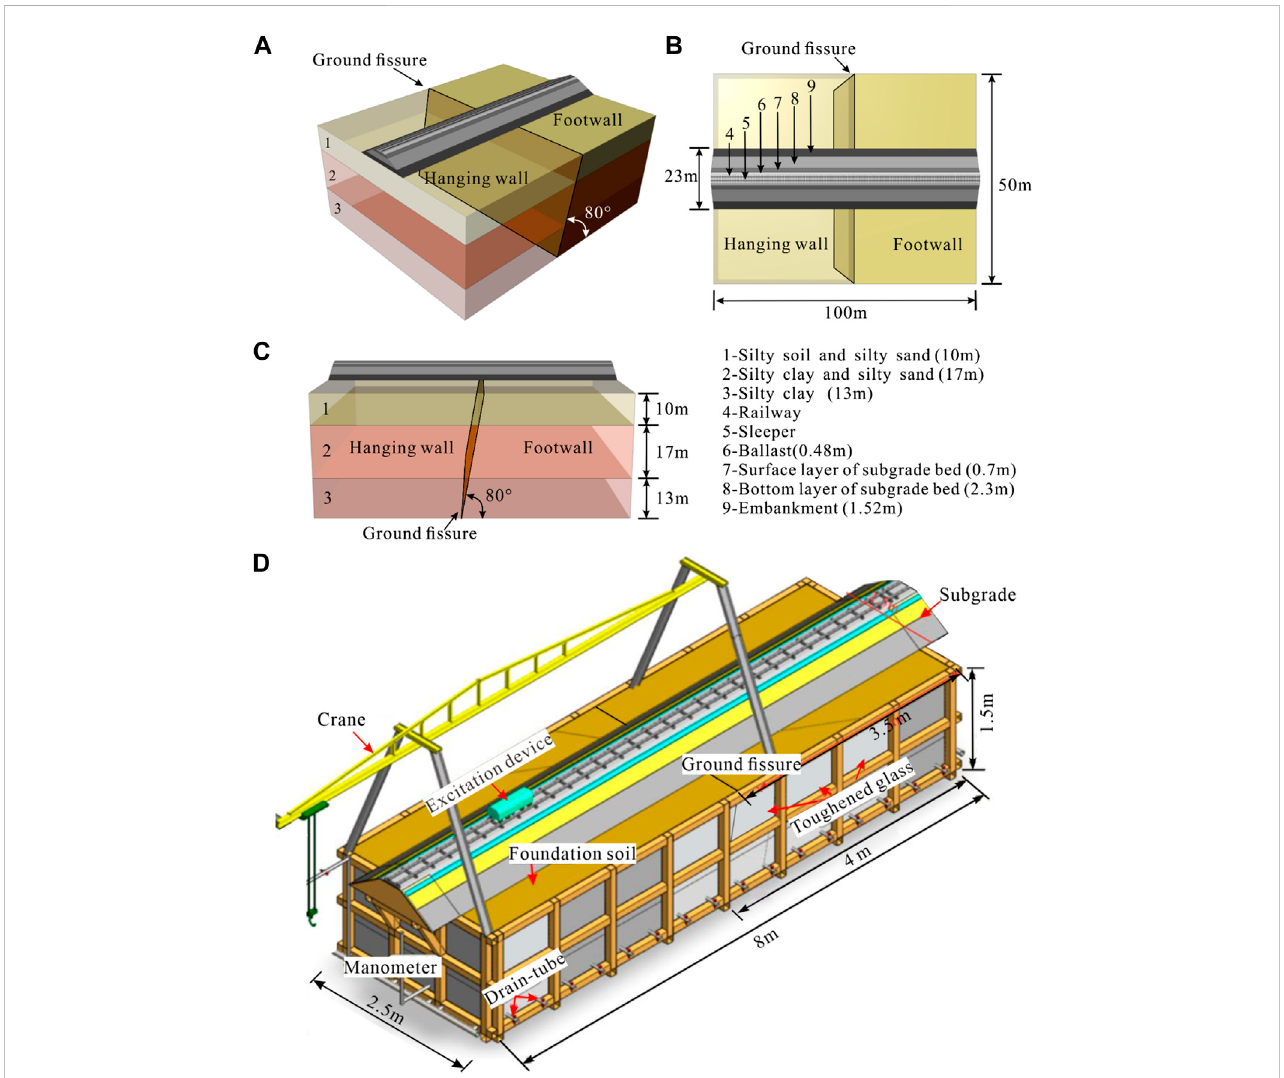
FIGURE 3 Schematic diagram of the DXPDL subgrade crossing TY3 ground fi ssure. (A) Three-dimensional view; (B) Overhead view; (C) Lateral view; (D) Three- dimensional schematic view of model test system.